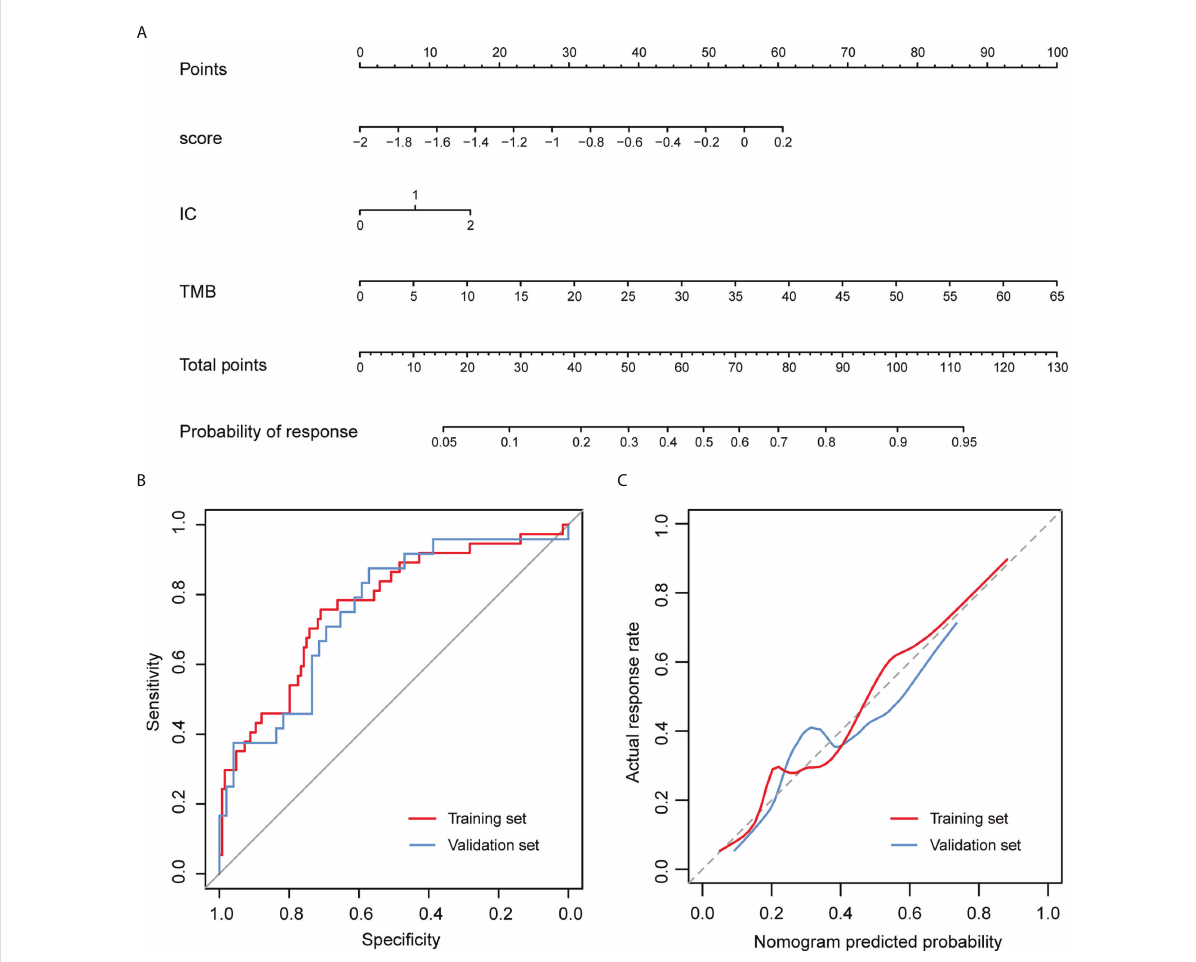
FIGURE 5 Nomogram to predict the response of atezolizumab treatment for patients with advanced urothelial carcinoma and its performance evaluation. (A) Points were assigned for gene score, IC and TMB by drawing a line upward from the corresponding values to the “ Points ” line. The sum of these three points, plotted on the “ Total points ” line, corresponds to predictions of the treatment response. (B) ROC curves of the nomogram. (C) Calibration curves of the nomogram. The observed treatment outcome is shown compared with the nomogram using the training set and validation set, respectively. The calibration curves depict the calibration of the nomogram in terms of the agreement between the predicted treatment outcomes and the observed treatment outcomes. The 45-degree dotted gray line represents a perfect prediction, and the solid lines represent the predictive performance of the nomogram. The distance between the solid line and the ideal line represents the superior predictive accuracy of the